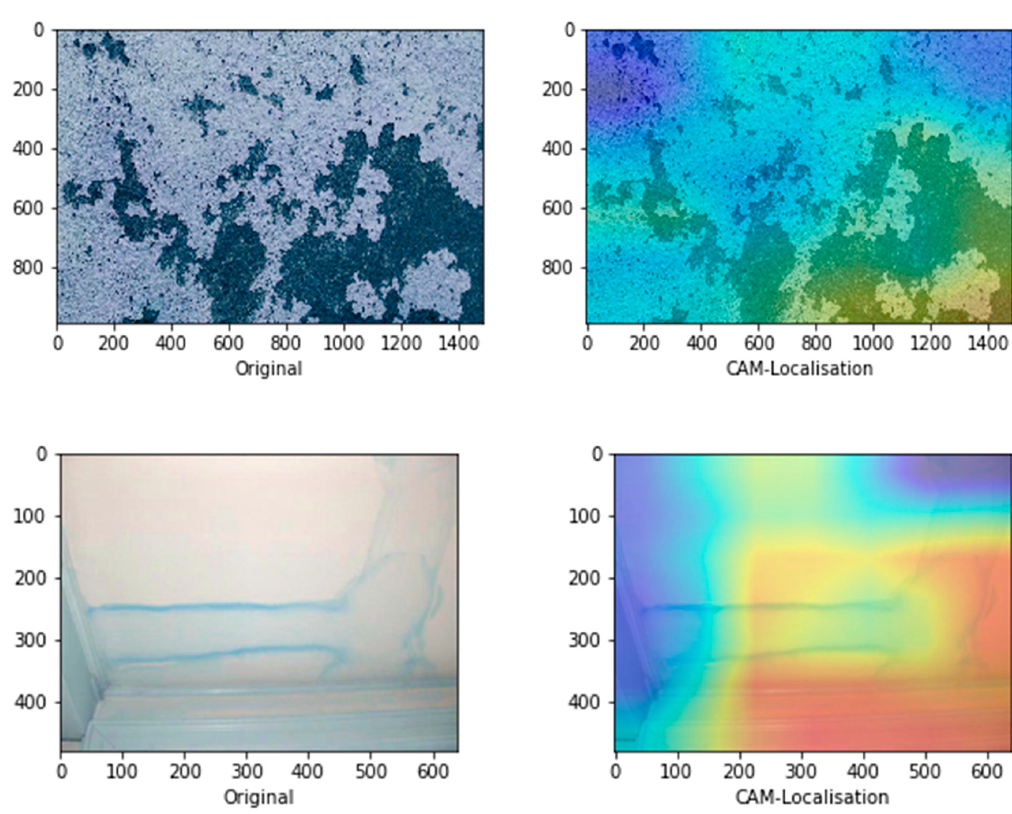
Figure 11. Incorrect localisation .